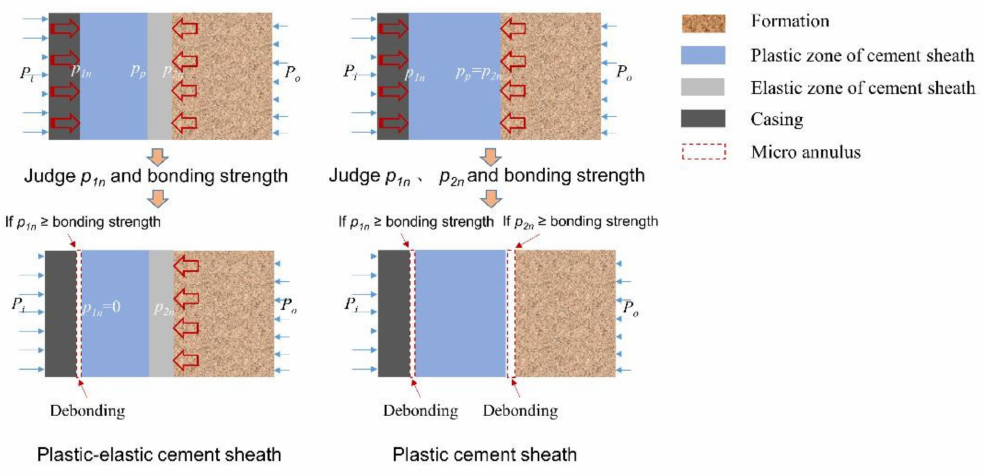
Figure 3. Schematic diagram of the micro annulus